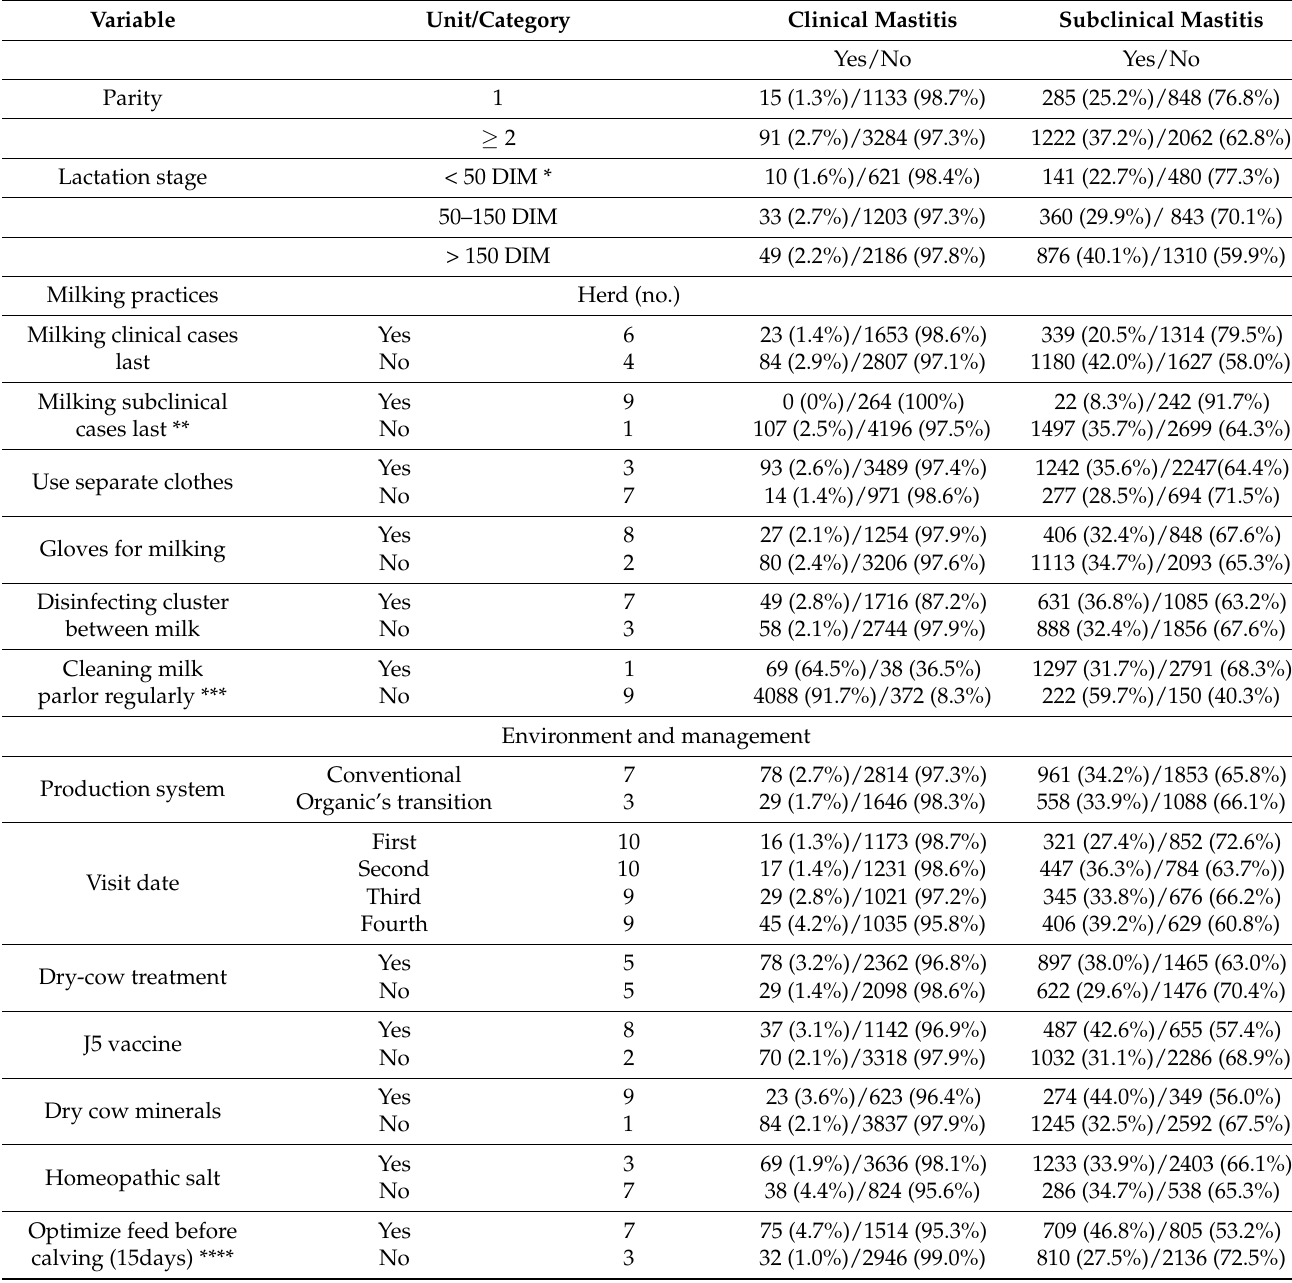
Table 1. Selected predictors included in the univariable models for cow and herd level analyses as risk factors for clinical and subclinical mastitis in lactating cows assessed in a longitudinal study on smallholder dairy farms ( n = 10) located in the southeast of